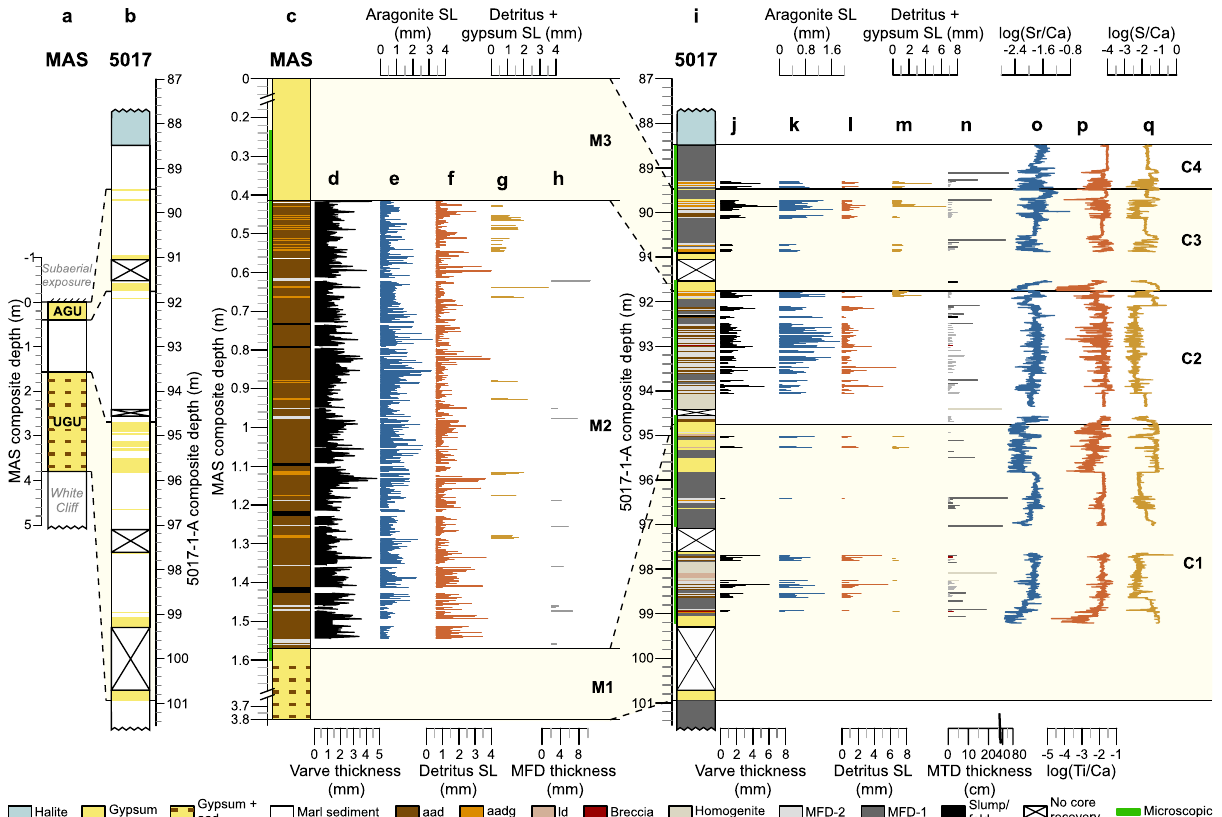
Figure 3. Sediment profiles at Masada and in the ICDP core. Overview of study intervals at Masada ( a , MAS) and the deep ICDP core ( b , 5017) on the same scale intervals for thickness comparison (see Fig. 2 for chronological details). UGU: Upper Gypsum Unit, AGU: Additional Gypsum Unit. ( c – h ) Zoom in at the MAS study interval: ( c ) lithological column, ( d ) varve thickness (mean 1.1 mm), ( e ) aragonite, ( f ) detritus